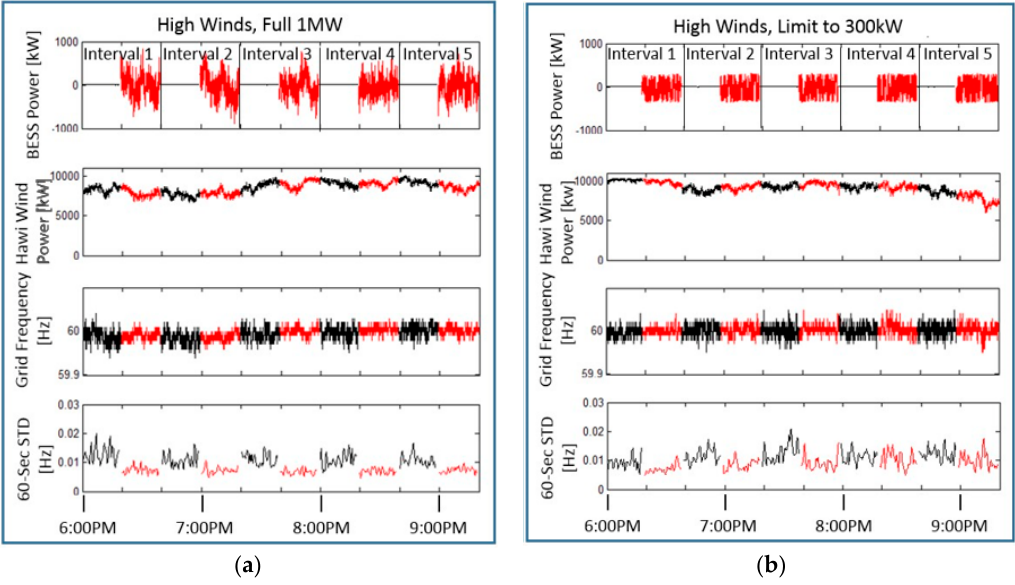
Figure 10. A comparison of two different days when total wind power output at Haw’i Renewable Development (HRD) and variability were similar. The gain setting used for the f-W curve of the BESS control algorithm was 30MW/Hz in both cases. The only difference is the limiting of the BESS output power, set to 1 MW for the left plots and 300 kW for the right plots. (Top) Time series of BESS real power output. (2nd from top) Time series of wind power at the HRD wind farm. (2nd from bottom) Time series of grid frequency. (bottom) The 60-seconds standard deviation of grid frequency.